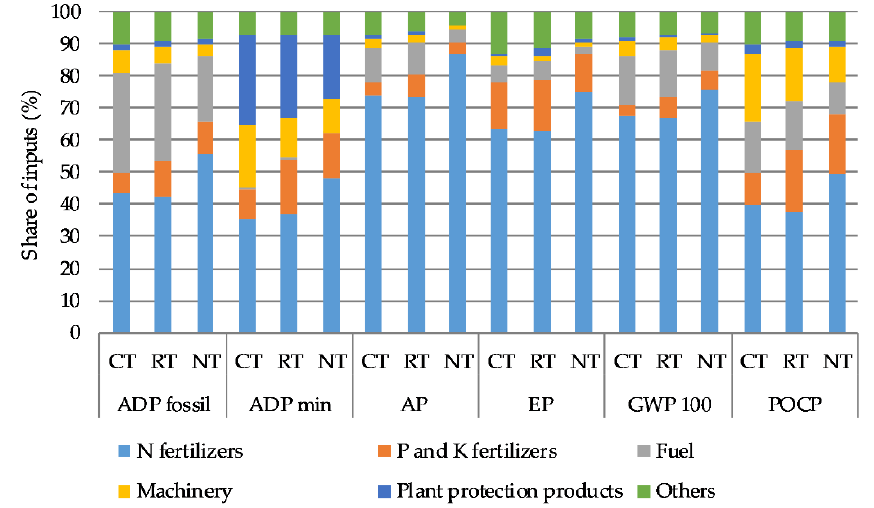
Figure 3. Contribution of the category inputs to the environmental impacts of winter wheat production in conventional tillage (CT), reduced tillage (RT), and no-tillage (NT). ADP fossil, abiotic resources depletion potential for fossil fuels; ADP min, abiotic resources depletion potential for minerals; AP, acidification potential; EP, eutrophication potential; GWP 100, global warming potential; POCP, photochemical ozone creation potential.